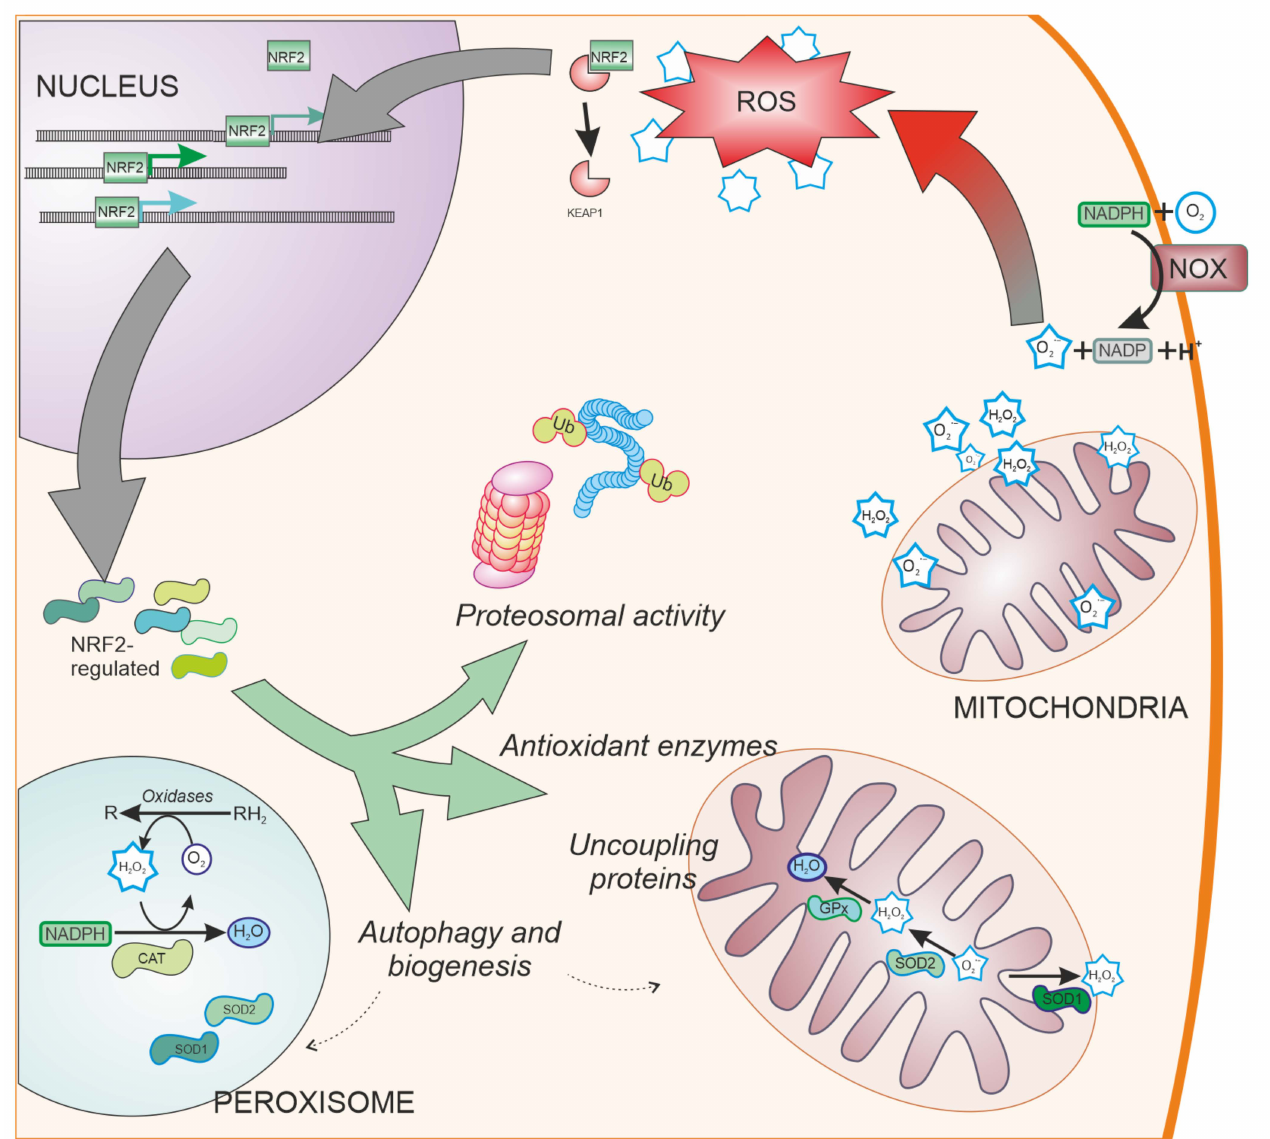
Figure 3. NRF2-regulated systems. Besides ROS scavengers located in the cytoplasm, organelles involved in oxygen metabolism such as mitochondria and peroxisomes, contain NRF2-regulated antioxidant enzymes specialized in the antioxidant metabolism such as catalase (CAT), superoxide dismutase type 1 and type 2 (SOD1 and SOD2, respectively), and peroxidases. Additionally, NRF2 regulates other cell pathways involved in reducing oxidative stress production, such as elimination of proteins by proteosomal degradation or autophagy and organelle biogenesis. NOX: NADPH oxidase. Ub: Ubiquitin. CAT: